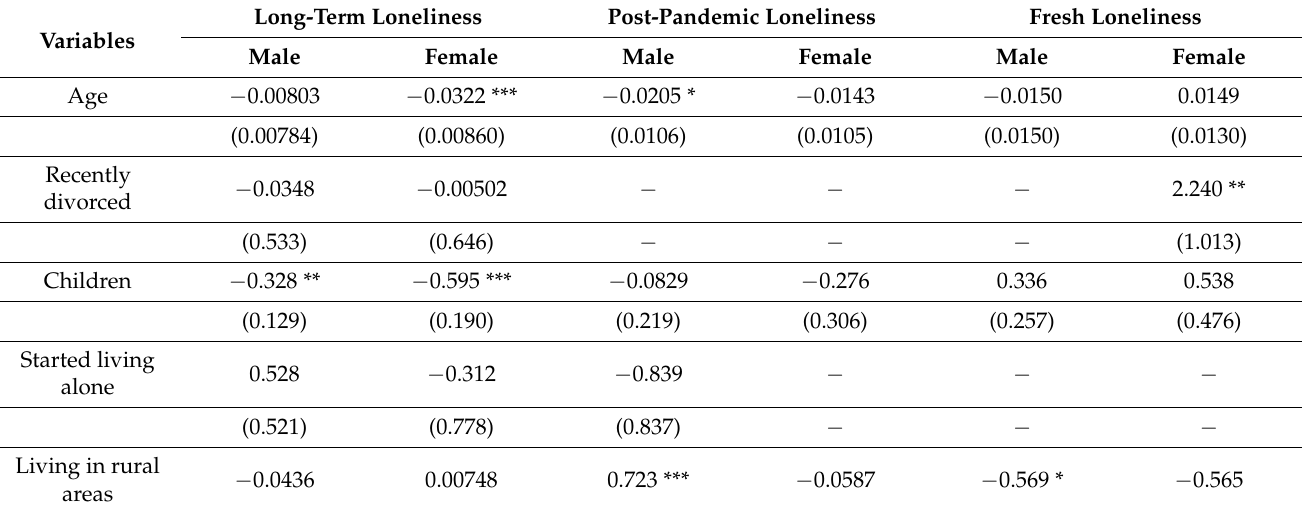
Table 7. Regression results for long-term, post-pandemic, and fresh loneliness, stratified by gender.